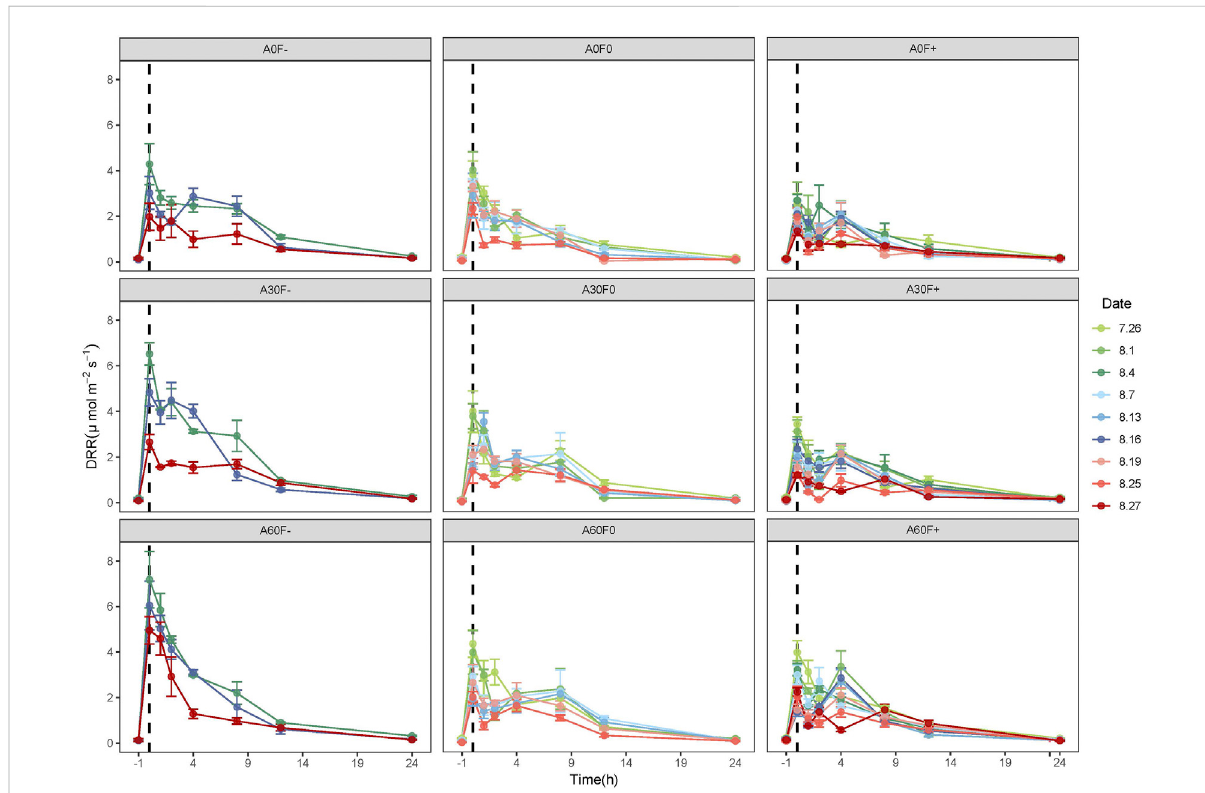
FIGURE 3 Dynamics of DRR in soil covered with cyanobacterial crust. -1 is the value determined before water application; 7.26, and 8.1, etc., are the experimental dates. DRR: dark respiration